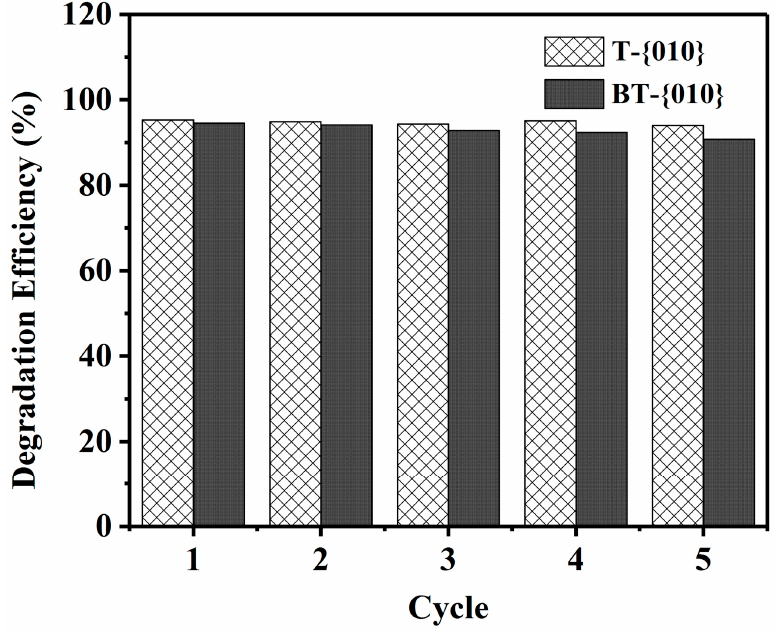
Figure 6. Degradation efficiency of T-{010} and BT{010} for five cycles.